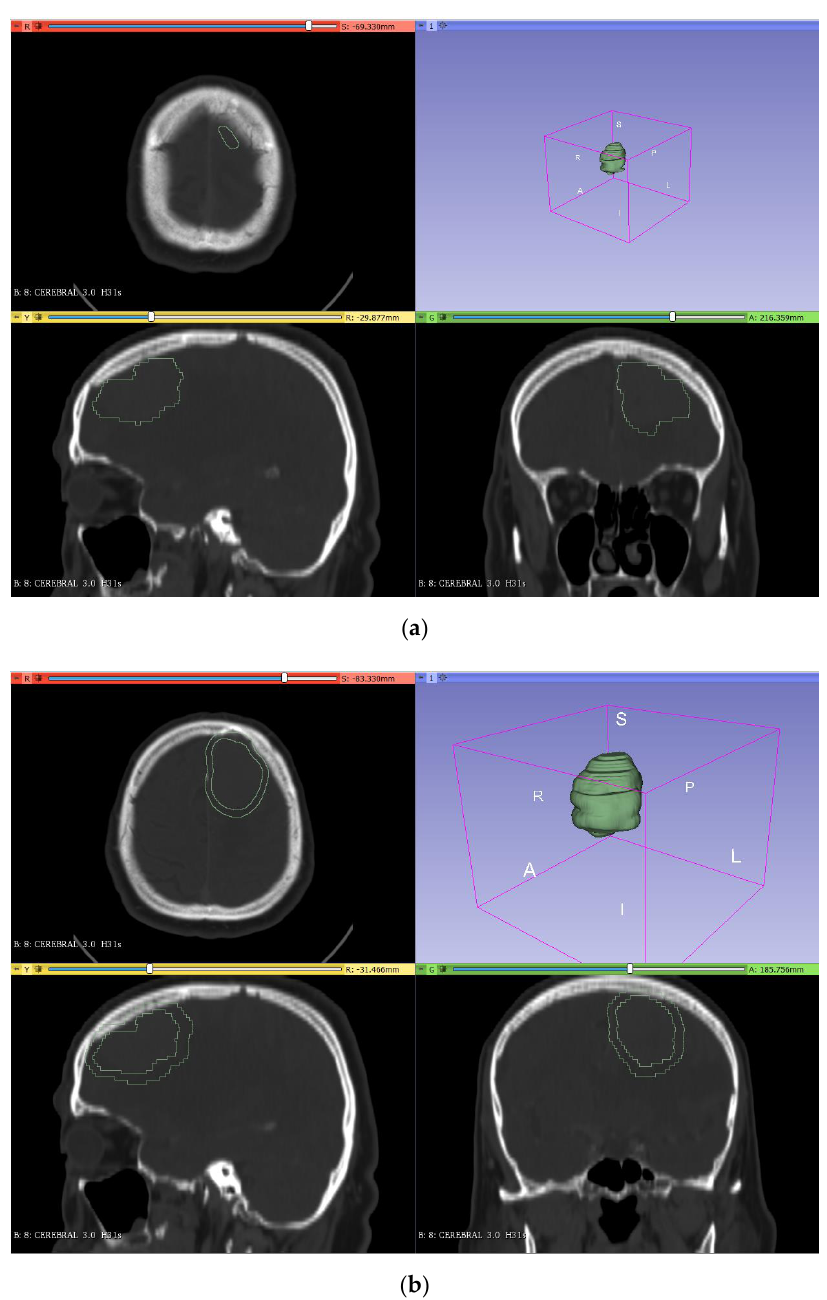
Figure 3. Segmentation ( a ) and creation of the tumor mold ( b ) from the DICOM images in 3DSlicer.